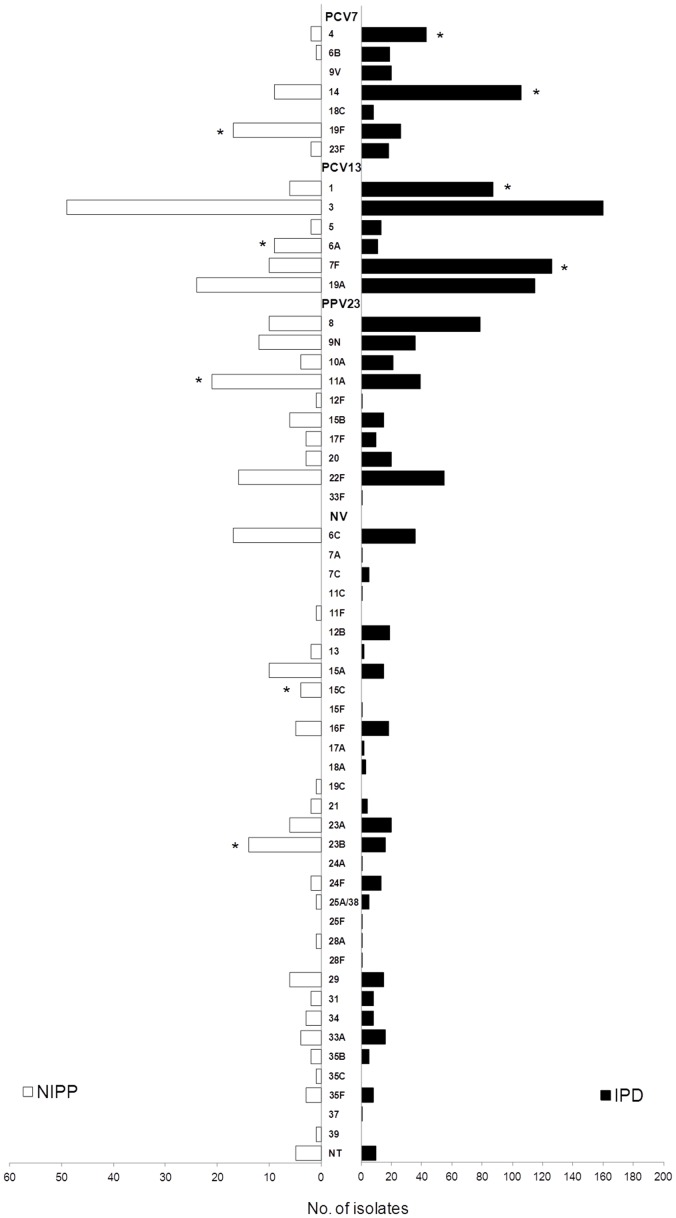
Serotype distribution of the isolates causing non-invasive pneumococcal pneumonia and invasive pneumococcal disease in adults in Portugal (2009–2011).Data from IPD were published previously [19]. Serotypes associated with NIPP or IPD are marked by asterisks. The odds ratio was used to measure the association between serotype and disease presentation and only significant values (P<0.05) after FDR correction are indicated. The P values for the serotypes associated with NIPP were: P = 0.001 for 19F, P = 0.007 for 6A, P = 0.004 for 11A, P = 0.001 for 15C, P<0.001 for 23B. The P values for the serotypes associated with IPD were: P = 0.007 for 4, P<0.001 for 14, P<0.001 for 1 and P<0.001 for 7F.